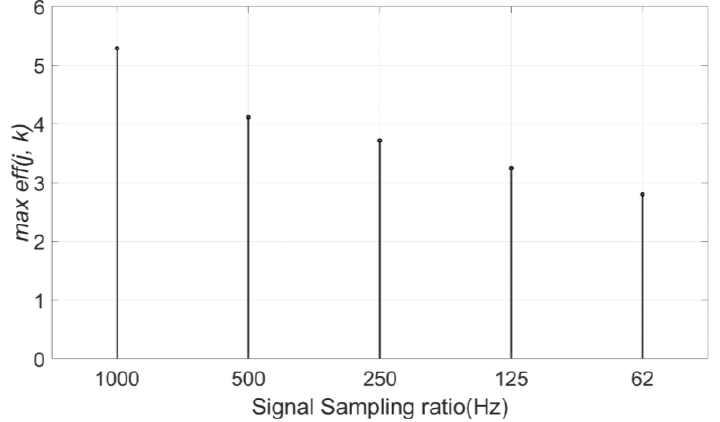
Figure 11. Maximum 𝑒𝑓𝑓(𝑗, 𝑘) values of signals with five sampling ratios (1000 Hz, 500 Hz, 250 Figure 11. Maximum ef f ( j , k ) values of signals with five sampling ratios (1000 Hz, 500 Hz, 250 Hz, Hz, 125 Hz, and 62 Hz). 125 Hz, and 62 Hz).